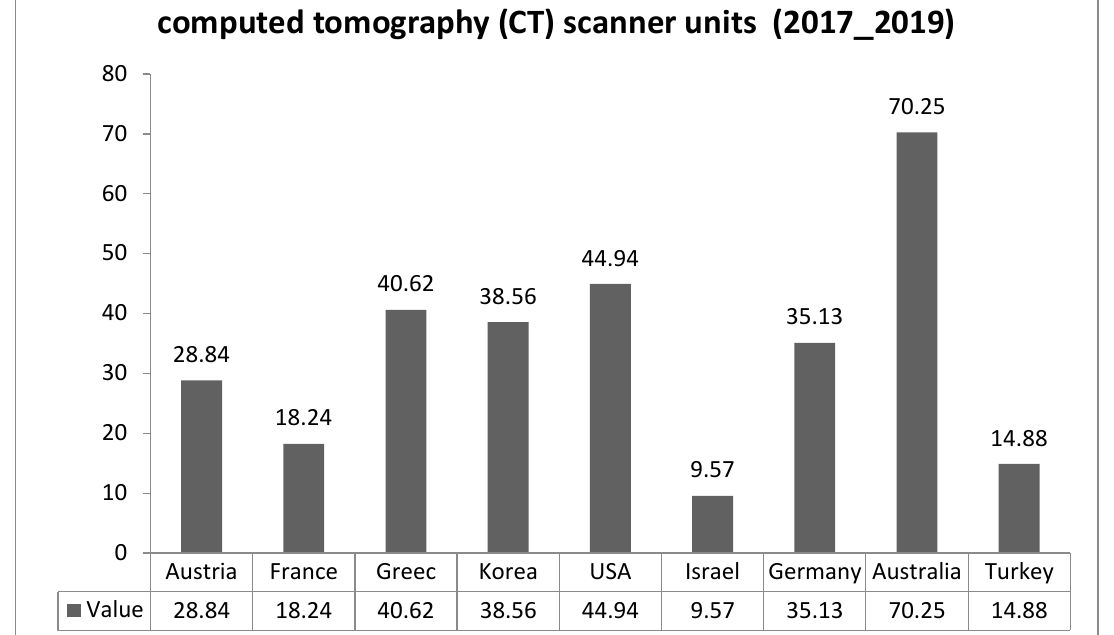
Figure 2. Distribution of Magnetic resonance imaging (MRI) units in the selected countries Figure 1. Distribution of computed tomography (CT) scanner units in the selected countries /per (Total/per million population). million